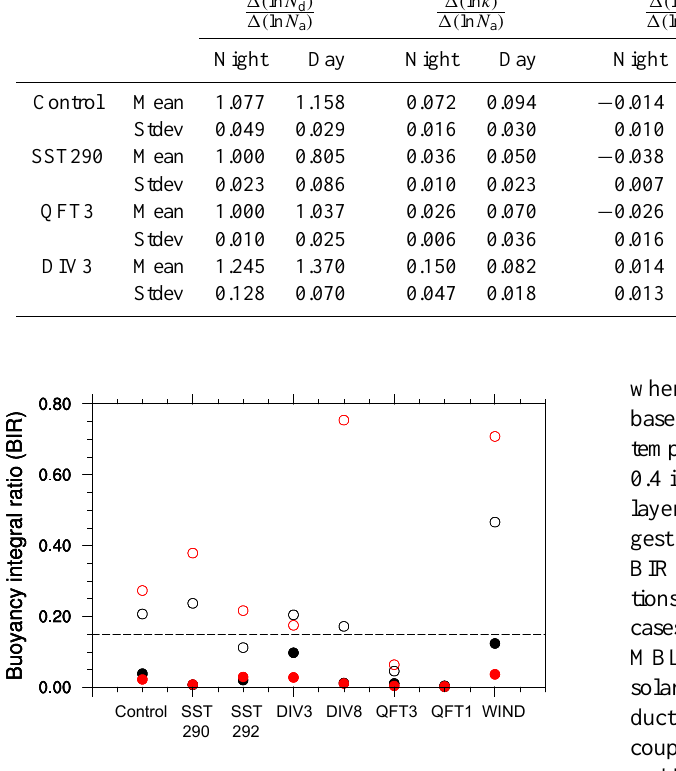
Fig. 14. The buoyancy integral ratio ( BIR ) for clean ( N a =100cm − 3 ) nighttime (4 - 7 h, black), clean daytime (12 - 15 h, black open circle), polluted ( N a =1000cm − 3 ) nighttime (red), and polluted daytime (red opencircle)cloudsunderdifferentenvironmentalconditions. Thedashedlinecorrespondstocriticalvalue0.15 (suggested by Bretherton and Wyant (1997)).